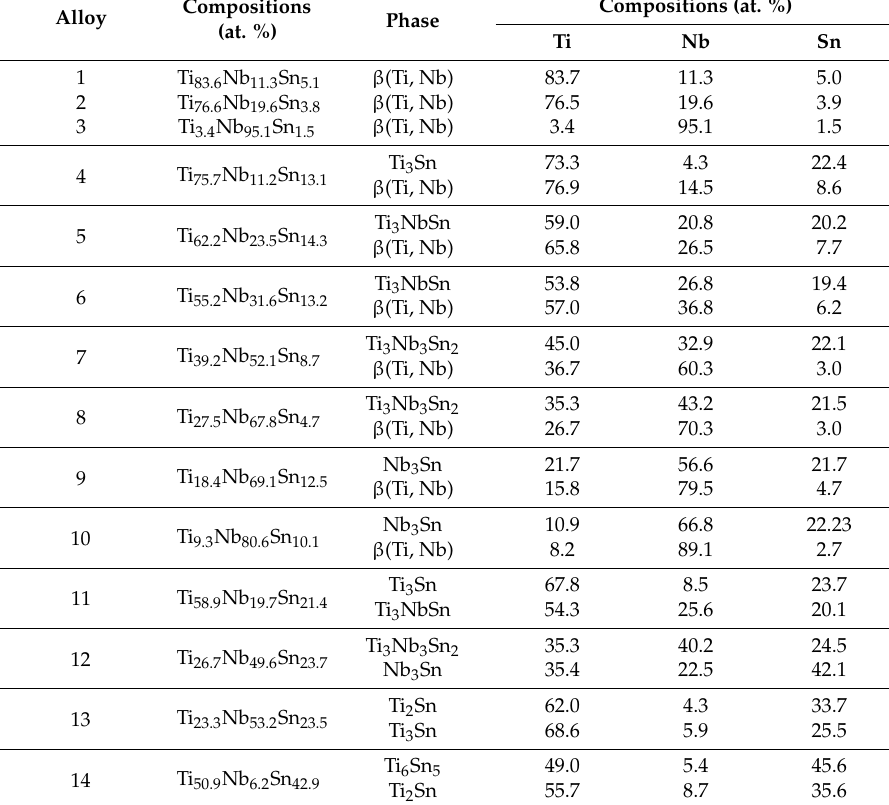
Compositions (at.